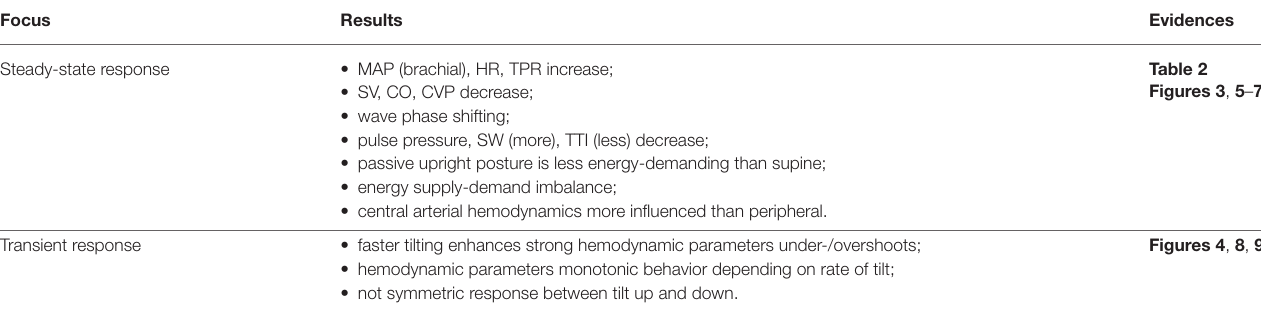
TABLE 3 | The main findings of our analysis on passive assumption of upright posture at different degree and rate of tilt. Focus